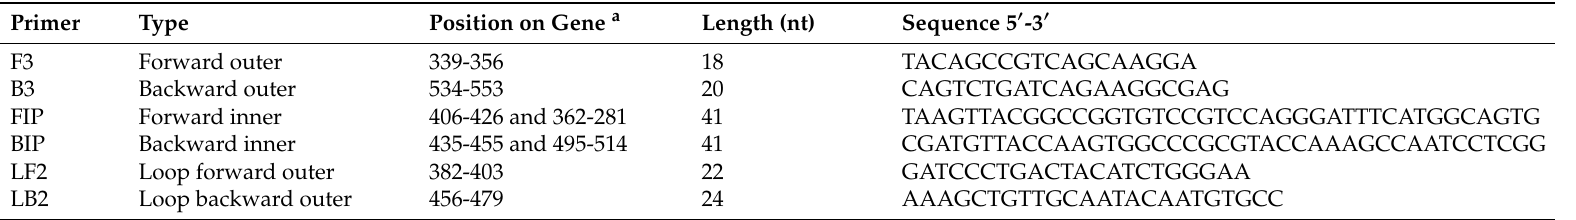
Table 4. Primer set GPA-FDS1 used for loop-mediated isothermal amplification of green-peach aphid (GPA; Myzus persicae )